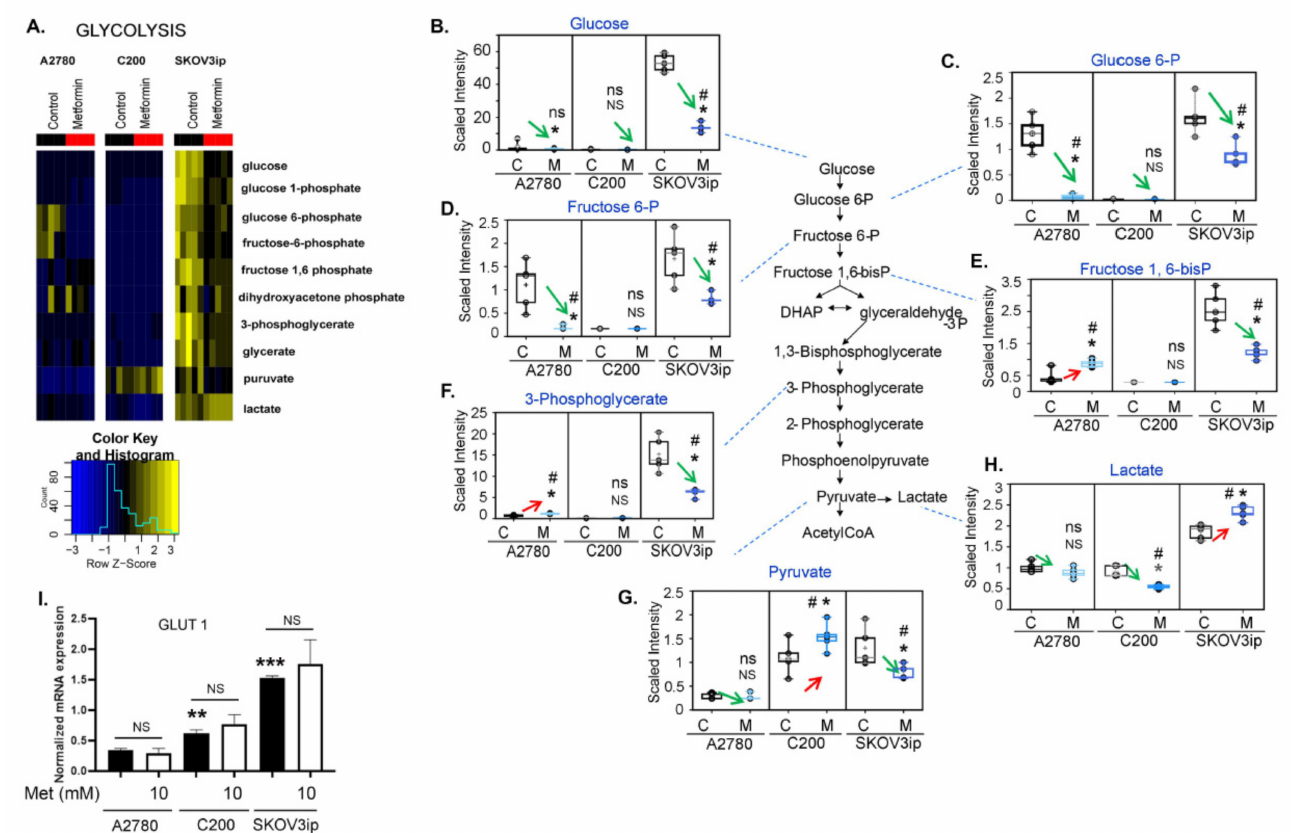
Figure 2. Effect of metformin on glycolysis cycle intermediates is cell-line specific. Selective analysis of glycolysis metabolites from the untargeted metabolomics was performed in untreated control (C) and 10 mM metformin (M)-treated cells. ( A ) Heatmap showing alterations in glycolysis cycle metabolites in A2780, C200, and SKOV3ip cells. Scaled metabolite intensity graphs showing levels of ( B ) glucose, ( C ) glucose-6-phosphate (glucose 6-P), ( D ) fructose 6-phosphate (fructose 6-P), ( E ) fructose 1,6- bisphosphate (fructose 1,6-biP), ( F ) 3-phosphoglycerate, ( G ) pyruvate, and ( H ) lactate in A2780, C200, and SKOV3ip cells in response to metformin (10 mM). For all box-plot graphs, * p ≤ 0.05, NS = p non- significant, # q ≤ 0.05, ns = q non-significant when metformin treated compared to control. ( I ) mRNA expression of glucose transporter (GLUT-1) in metformin (10 mM) ** p ≤ 0.01 and *** p ≤ 0.001, metformin treated compared to